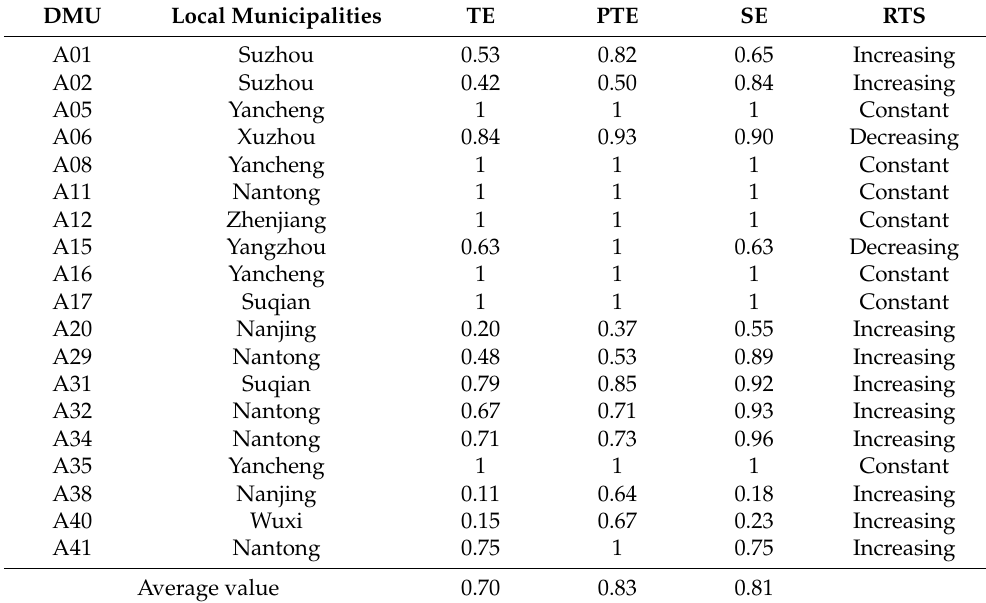
Table 8. Phase III investment efficiency values for the 19 projects for meeting electricity demand (sorted by